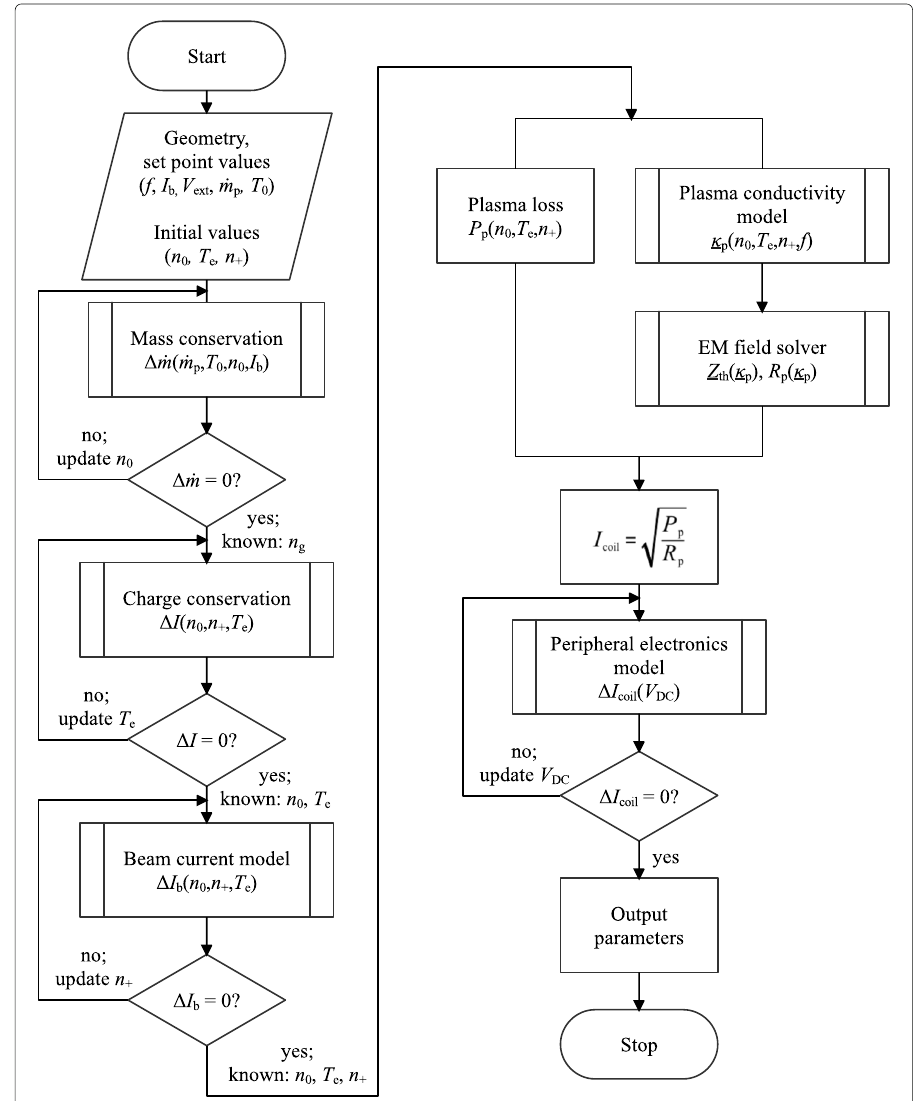
Fig. 6 Flow chart if the 3D